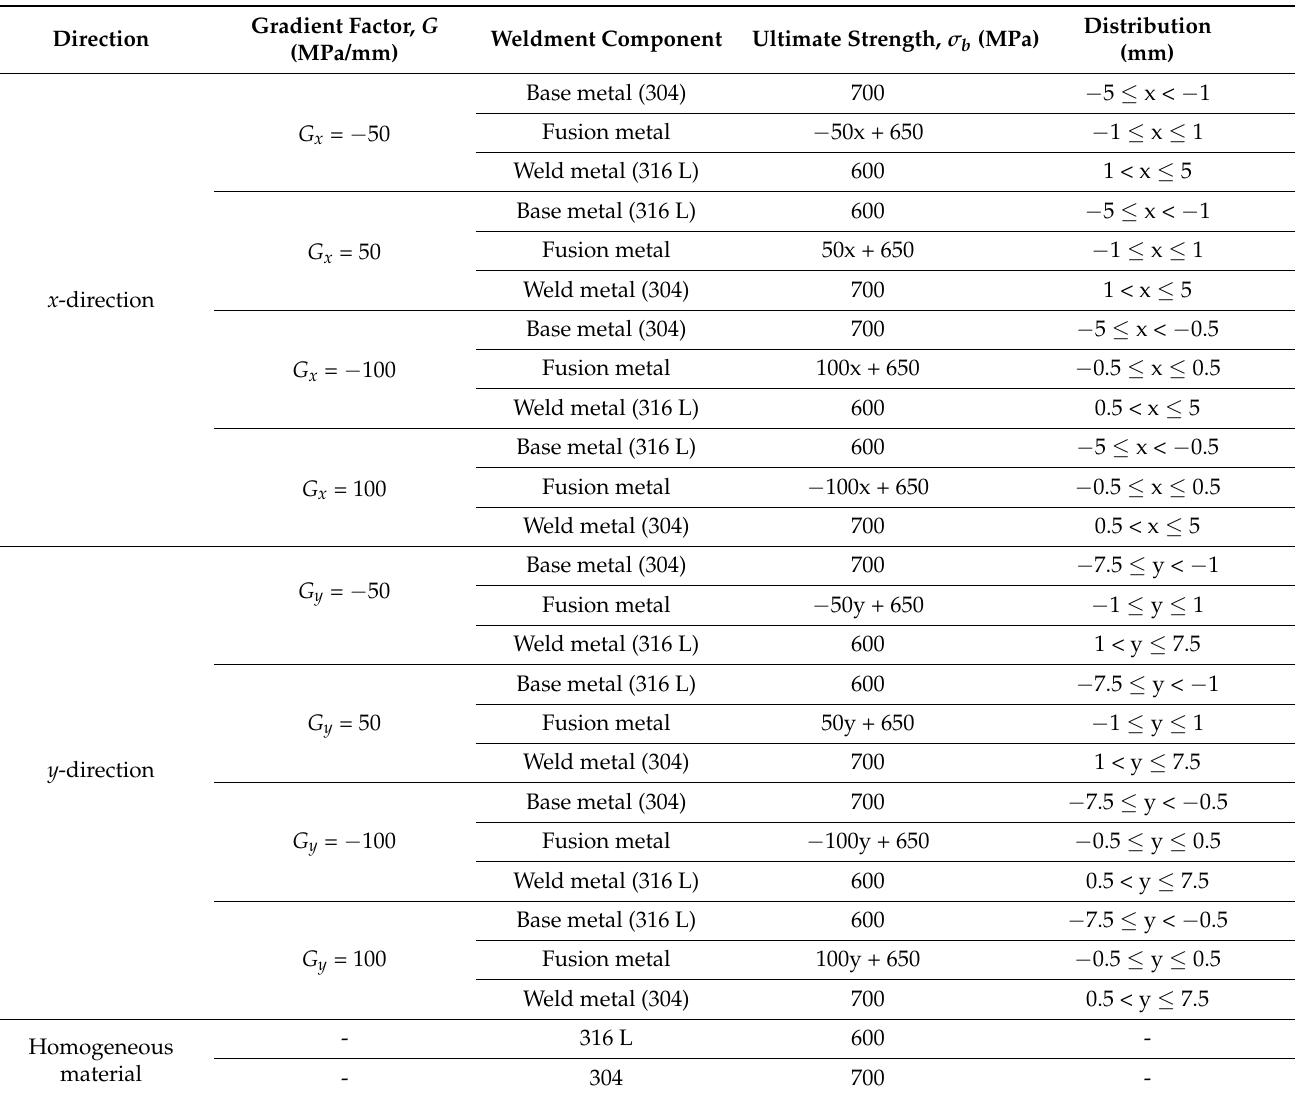
Table 1. Material ultimate strength of welded joint finite element